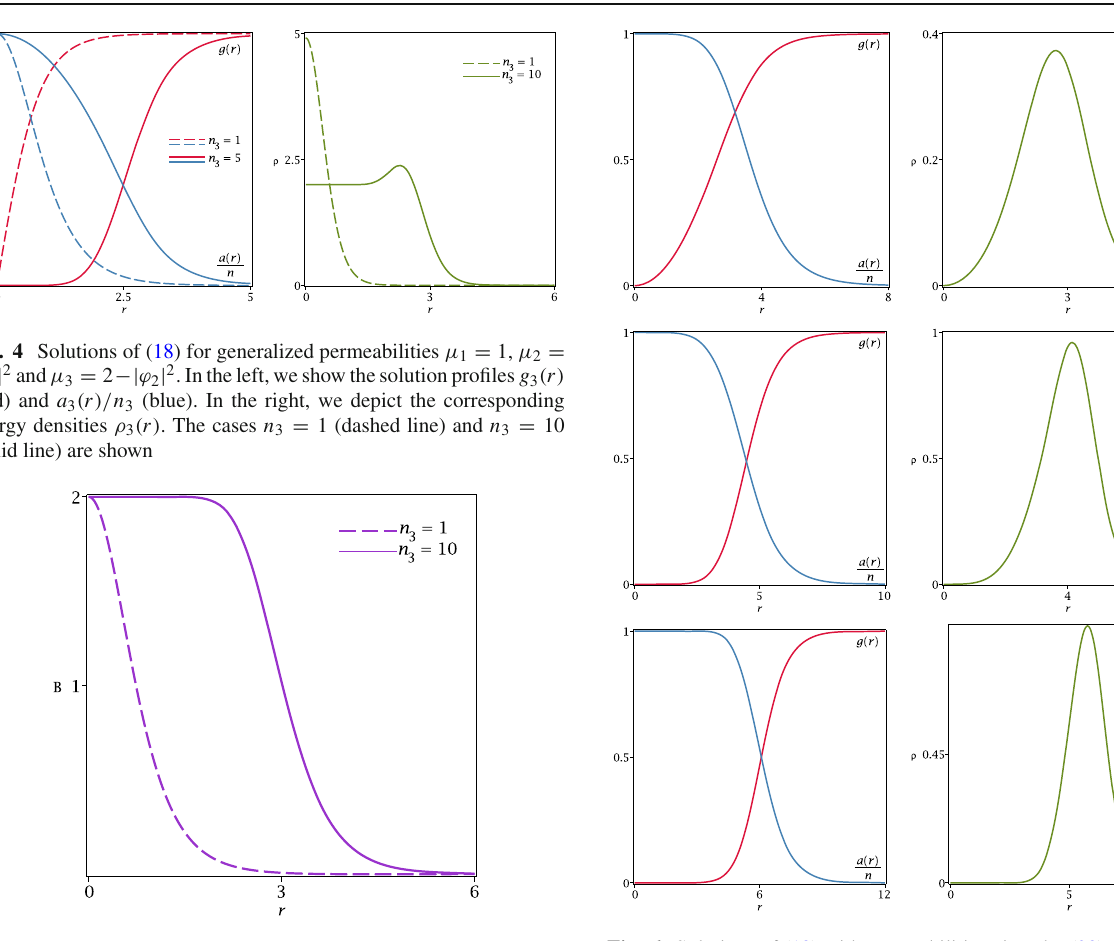
Fig. 5 Magnetic inductions from sector 3 for the model specified by (27). We depict the cases n 1 = 1 (solid line) and n 2 = 10 (dashed line)